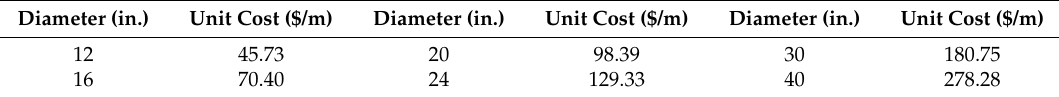
Figure 2. Layout of Hanoi network (HAN) [20]. Table 2. Diameter options and associated unit costs of Hanoi network